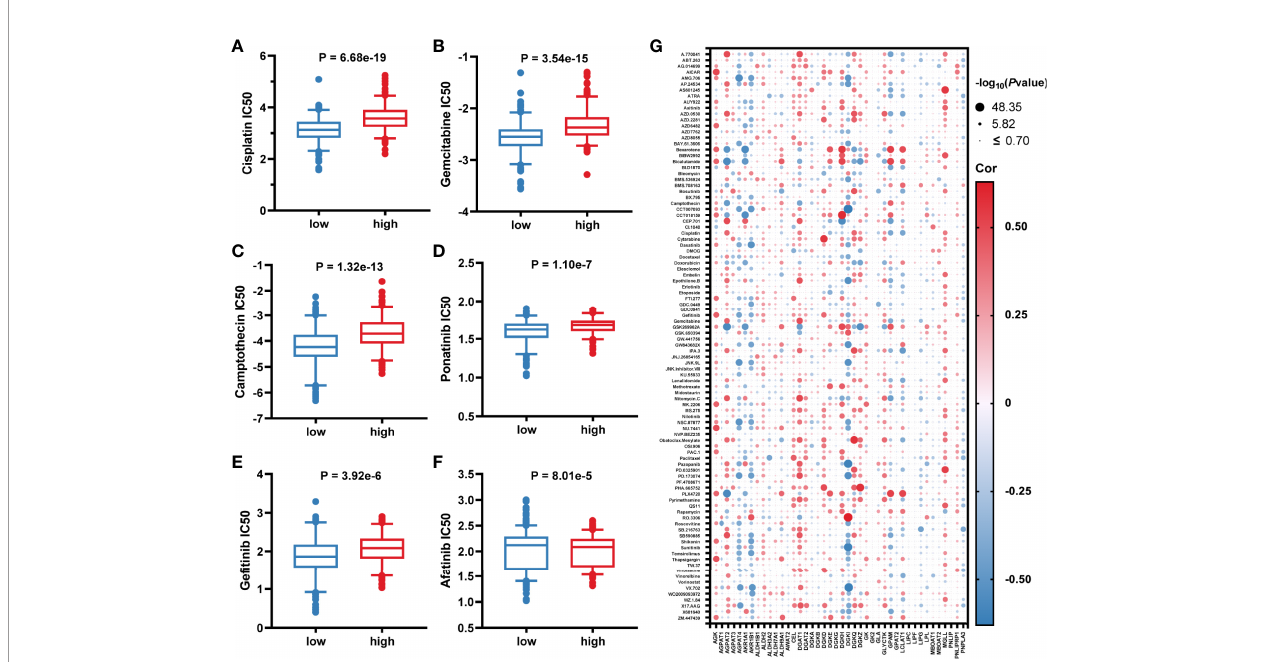
FIGURE 5 | Association between glycerolipid metabolism score and drug sensitivity. (A – F) The correlation between glycerolipid metabolism scores (GLMS) of cell samples and estimated half-maximal inhibitory concentration (IC50) value of drugs including cisplatin (A) , gemcitabine (B) , camptothecin (C) , ponatinib (D) , ge fi tinib (E) , and afatinib (F) . (G) The correlation between glycerolipid metabolism-related genes and estimated IC50 value of 96 drugs.